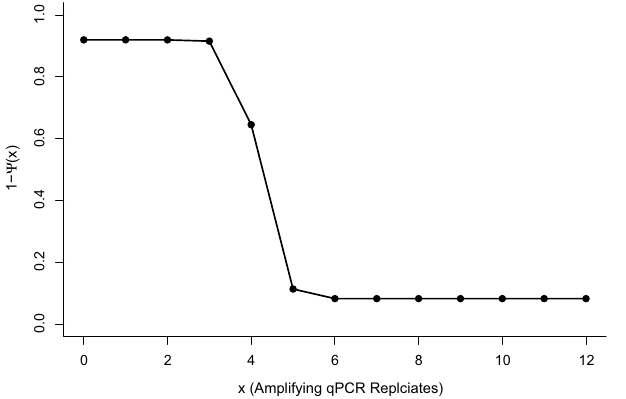
Figure 7. The posterior conditional probabilities of species absence (1 − ψ (x)), given x amplifying qPCR replicates, calculated using the Griffin et al . 16